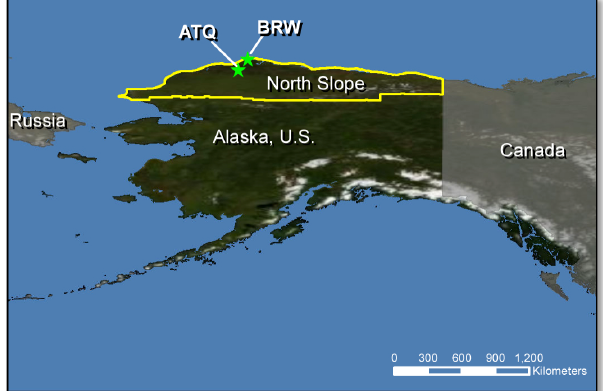
Figure 1. Map of the Alaskan Arctic North Slope delineation, and the two AmeriFlux sites used in this study (Atqasuk: ATQ; Barrow: BRW).